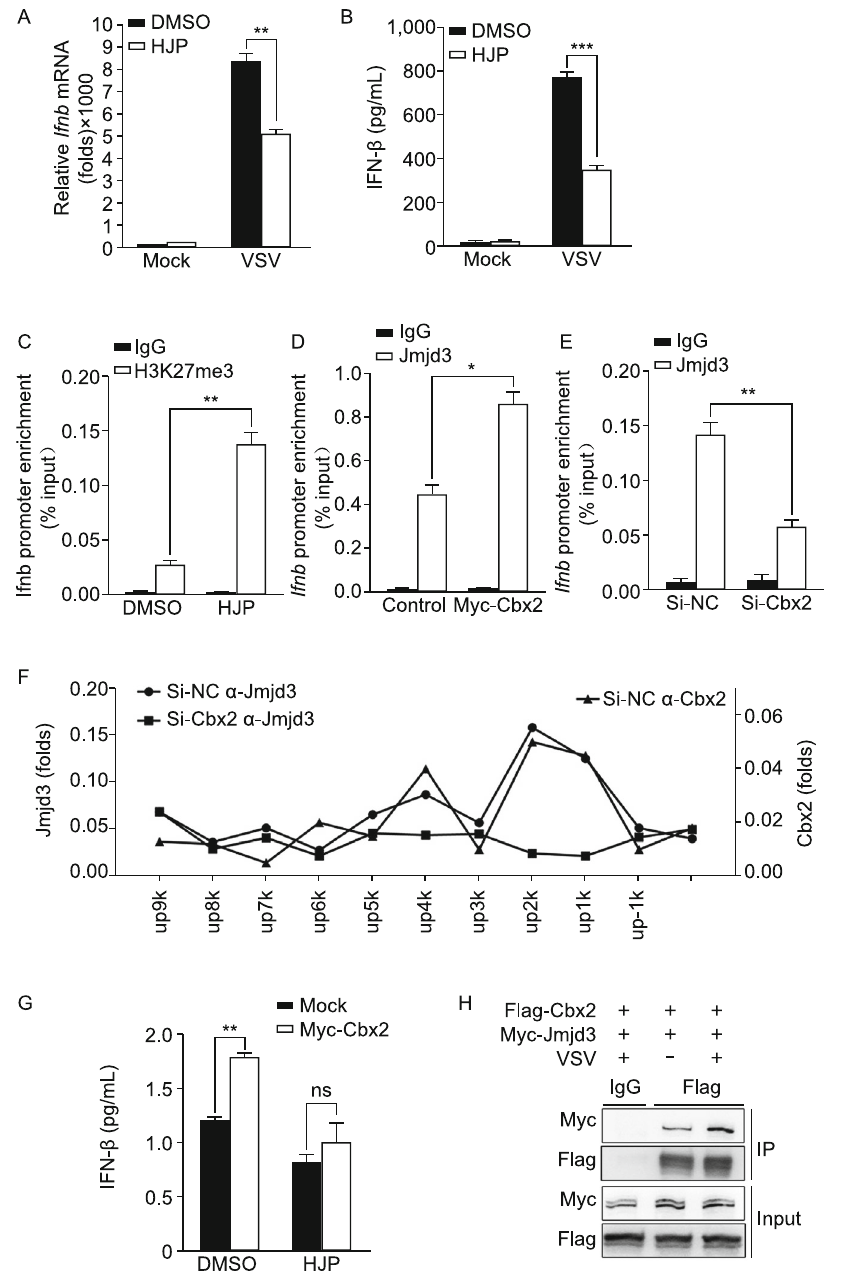
Figure 6. Cbx2 enhances the activation of IFN- β activation by binding to Jmjd3. (A) Q-PCR analysis of Ifnb expression, and (B) ELISA analysis of IFN- β in supernatants from mouse peritoneal macrophages treated with Jmjd3 inhibitor (HJP) for 6 h, and then infected with or without VSV (MOI = 10) for 6 h. (C) ChIP analysis of H3K27me3 at the Ifnb promoter in mouse peritoneal macrophages treated with HJP for 6 h, and then infected with VSV (MOI = 10) for 8 h. (D and E) ChIP analysis of Jmjd3 at the Ifnb promoter in Myc-Cbx2 RAW264.7 cells (D) or mouse peritoneal macrophages transfected with Si-NC or Si-Cbx2 (E). Cells were infected with VSV (MOI = 10) for 6 h. (F) ChIP analysis of Jmjd3 and Cbx2 at different regions of the Ifnb promoter in control or Cbx2- knockdown macrophages. (G) ELISA analysis of IFN- β in supernatants mock or Myc-Cbx2 RAW264.7 cells treated with or without with HJP for 6 h. (H) Western blot analysis of the interaction of Cbx2 and Jmjd3 in HEK293T cells transfected with Cbx2 and Jmjd3 expression plasmid. The proteins were immunoprecipitated with IgG or an anti-Flag antibody prior to immunoblotting. The data in panels (A – G) are from three independent experiments (mean ± SEM of technical triplicates). All data are representative of three independent experiments with similar results. * P < 0.05; ** P < 0.01; *** P <